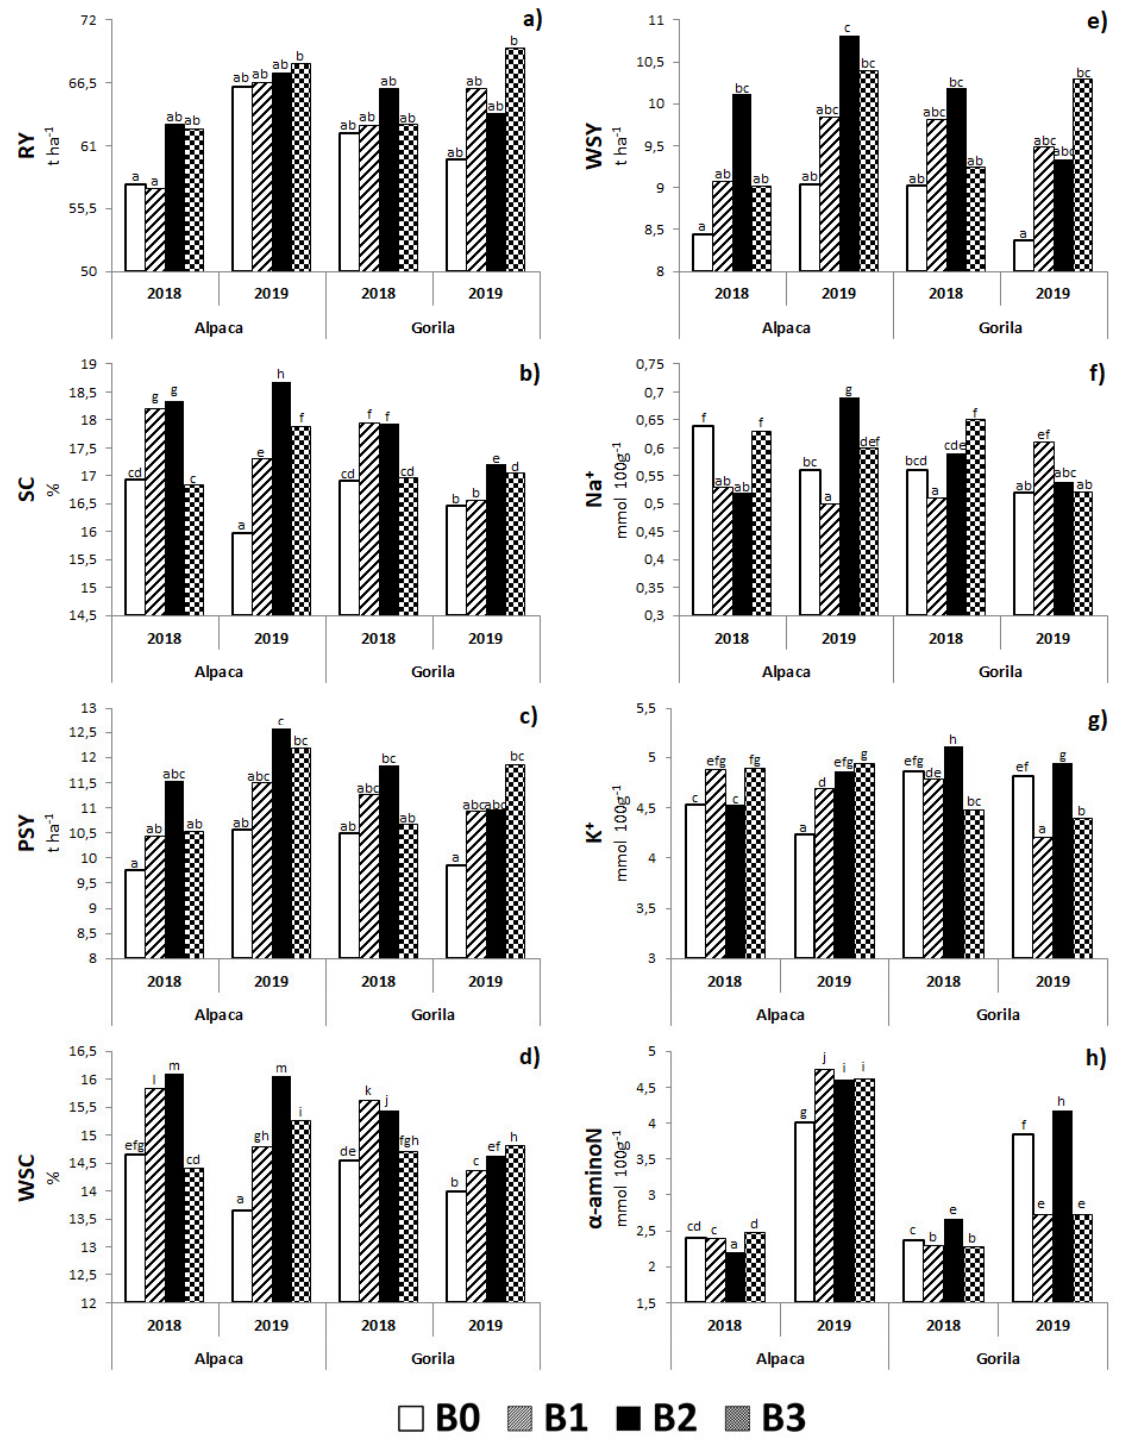
Figure 7. Interactions between biostimulants, years, and varieties for root yield ( a ), sugar content ( b ), polarized sugar yield ( c ), white sugar content ( d ), white sugar yield ( e ), sodium content ( f ), potassium content ( g ) and α-aminonitrogen content ( h ). B0—control; B1—humic acids, essential amino acids; B2—essential amino acids biopolymers, soil bacteria; B3—humic acids, essential amino acids biopolymers, soil bacteria. The figure was obtained at a level of significance α = 0.05.